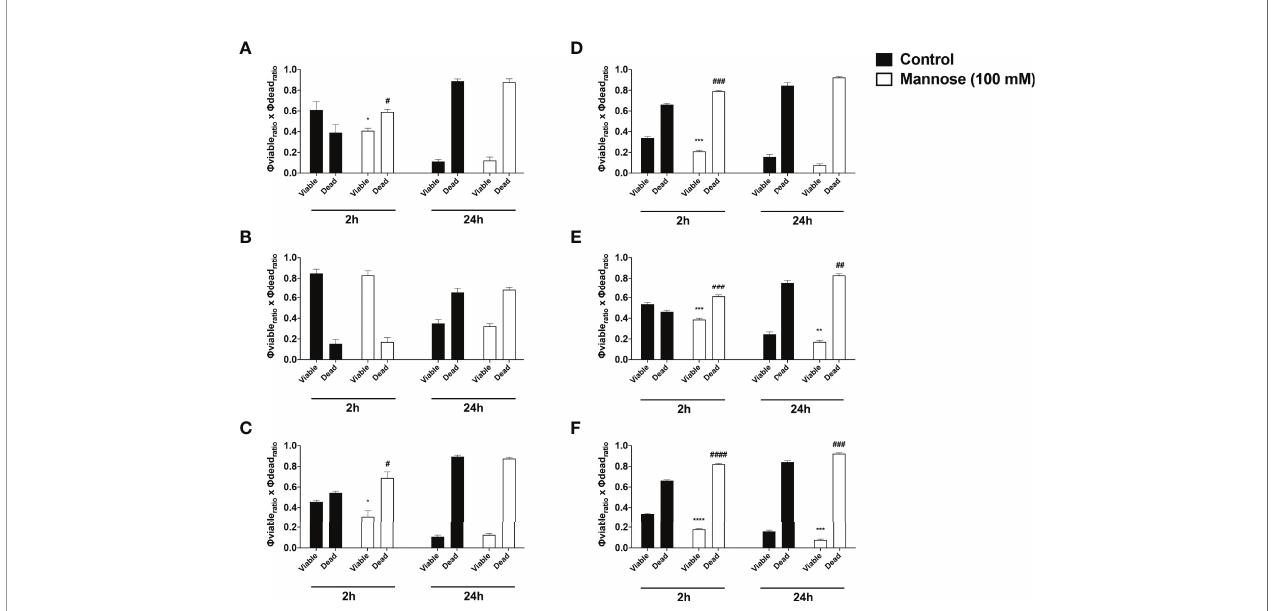
FIGURE 9 | Inhibition of mannose receptor impacts fungal survival inside Acanthamoeba castellanii and RAW macrophages. Fungal survival upon interactions with either (A – C) A. castellanii and (D – F) RAW 264.7 macrophages was evaluated for (A, D) Candida albicans , (B, E) Cryptococcus neoformans and (C, F) Histoplasma capsulatum were performed in the absence (Control group, black bars) and presence of 100 mM soluble mannose (Mannose 100 mM, white bars), and viability and mortality ratios were determined. The Mannose groups were compared to controls. Statistical differences are represented above each group (*p < 0.05, **p < 0.01, ***p < 0.001 or ****p < 0.0001 indicate statistically signi fi cant decrease upon mannose inhibition; # p < 0.05, ## p < 0.01, ### p < 0.001 or #### p < 0.0001 indicate statistically signi fi cant increase upon mannose inhibition; ns, not signi fi cant). The bars represent the average of three independent experiments, performed in